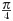
Anatomically accurate uterus model.(a) Uterus model with fixed conductivity tensor angle π4. (b) Uterus model with randomly sampled conductivity tensor angles.